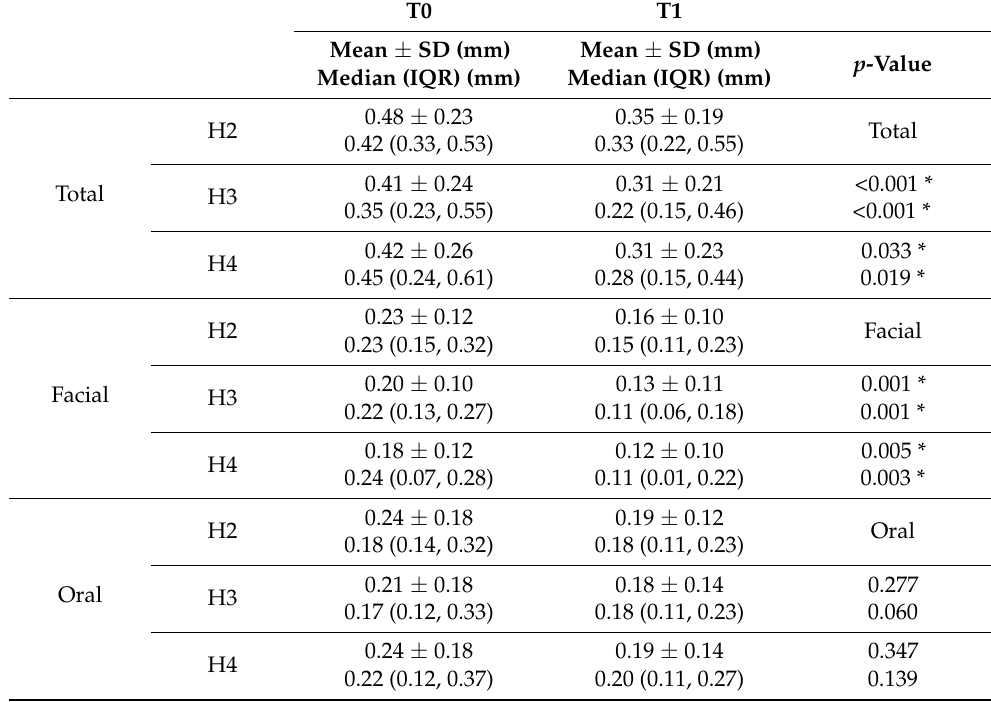
Table 2. Discrepancies between the two impression techniques at each time